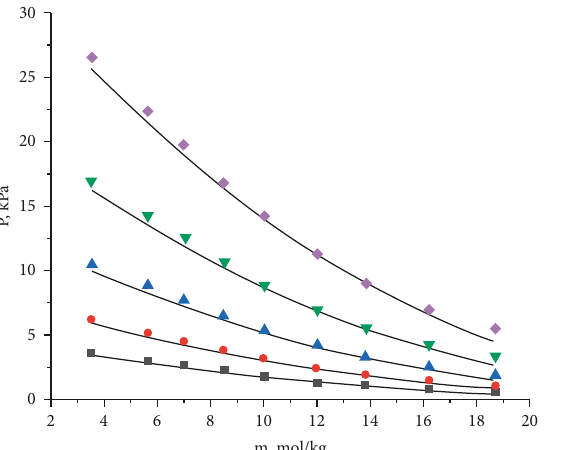
Figure 11: Calculation of the interaction data for the LiCl+H2O system. Symbols ( , T � 303.15K; , T � 313.15K; , T � 323.15K; , T � 333.15K, and , T � 343.15K :); VLE data; lines: